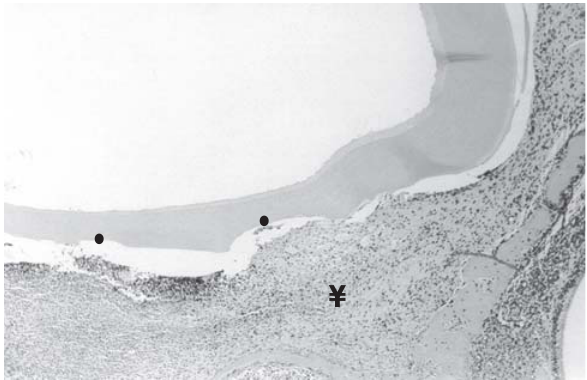
IIFIGURE 3 – Group I, 60 days – dense connective tissue oriented in parallel direction to the root surface (¥) and inflammatory resorption lacunae TABLE 2- Histological events on the root surface according at each study period in groups I and